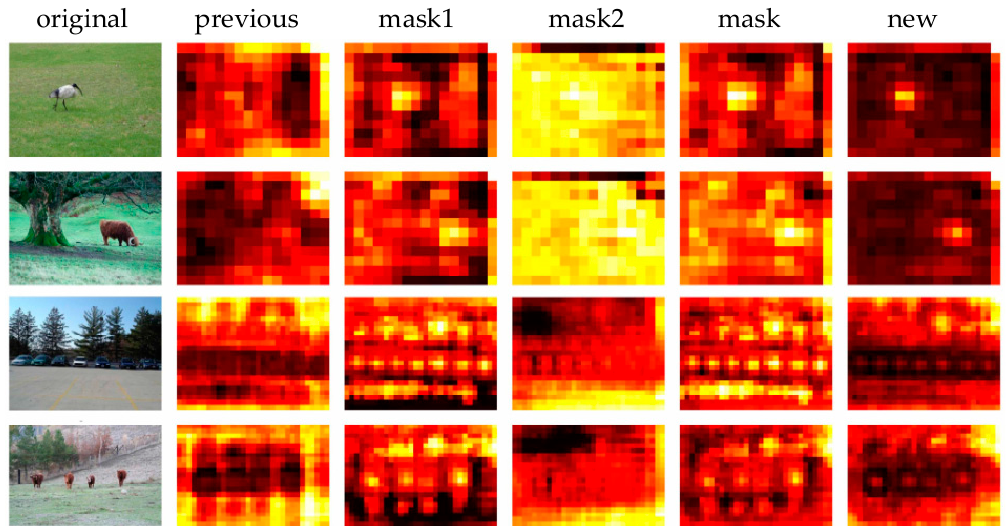
Figure 7. Visualization of feature maps. From left to right, the figure shows the original image (column 1), the previous feature maps after attention block (column 2), attention mask extracted by the branch with 1 × 1 kernels (column 3), attention mask extracted by the branch with 3 × 3 kernels (column 4), the fusion of attention mask (column 5), new feature maps output by the attention block (column 6).